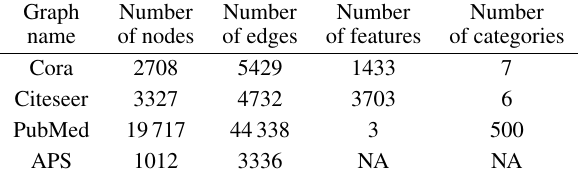
Table 1 Overview of the datasets used in our experiments. In APS, nodes represent published papers, and edges denote citation relations. We quantify the importance of the paper by computing the accumulated citations that a paper has received within the first 10 years after its publication.